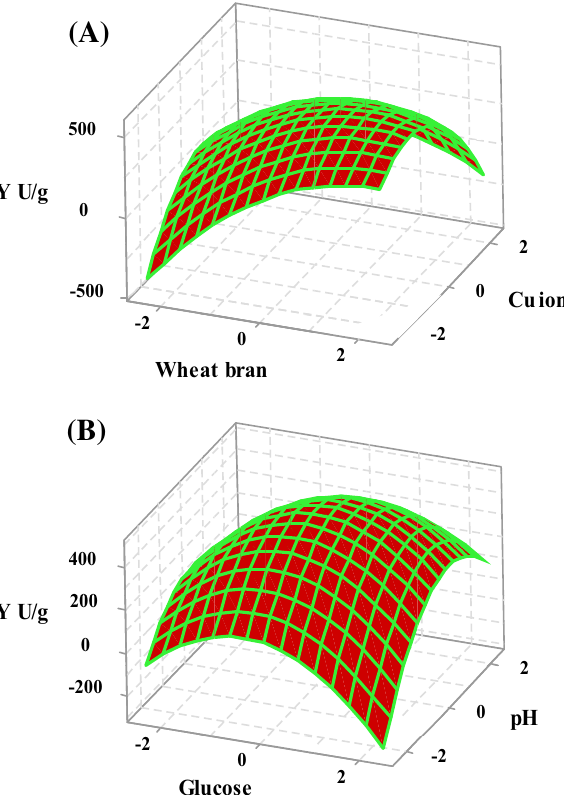
Fig. 2 3D response surface plots showing interactions between independent variables. a Wheat bran vs Cu 2 ? ions and b glucose vs pH affecting the laccase production